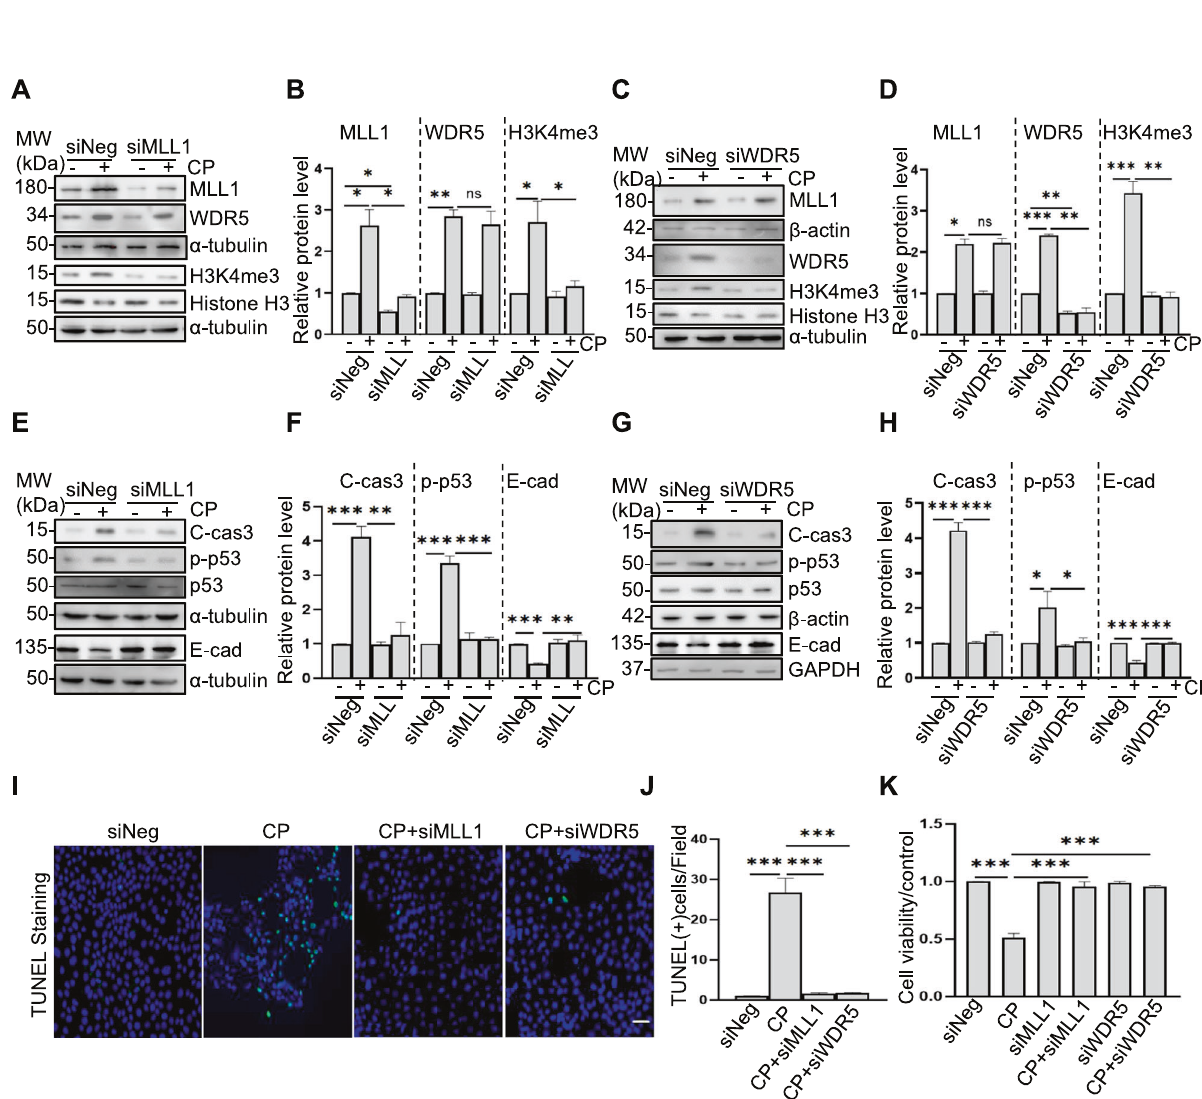
Fig. 4 Silencing of MLL1 and WDR5 inhibits apoptosis, reduces p53 phosphorylation, and retains E-cadherin (E-cad) expression in cultured murine renal proximal tubular cells (RPTCs) exposed to cisplatin (CP). Cultured RPTCs were transfected with negative control siRNA (siNeg) or speci fi c siRNA to MLL1 (siMLL1) or WDR5 (siWDR5) and then exposed to CP for another 24 h as described in “ Materials and Methods ” . A , C , E , G Cell lysates were prepared and subjected to immunoblot analysis with antibodies against MLL1, WDR5, H3K4me3, cleaved caspase3 (C-cas3), phospho-p53 (p-p53), p53, and E-cad as indicated. Expression levels of all those proteins were quanti fi ed by densitometry. MLL1 ( B , D left) and WDR5 ( B , D middle) were normalized with α -tubulin and β -actin, respectively; H3K4me3 ( B , D right) was normalized with histone H3. C-cas3 ( F , H left) was normalized with α -tubulin or β -actin, p-p53 ( F , H middle) was normalized with total p53, and E-cad ( F , H right) were normalized with α -tubulin or β -actin, respectively. I , J TUNEL staining was conducted 24 h after CP administered, and TUNEL-positive cells were calculated and shown by at least 10 fi elds per section. Scale bar = 20 μ m. K Cell viability was detected by cell counting kit 8 (CCK8) assay. Signal obtained from the control (Ctrl) sample was set as 1. Each representative blot from at least three experiments was shown. Values are mean ± SD. * P < 0.05, ** P < 0.01, *** P < 0.001. ns means not signi fi